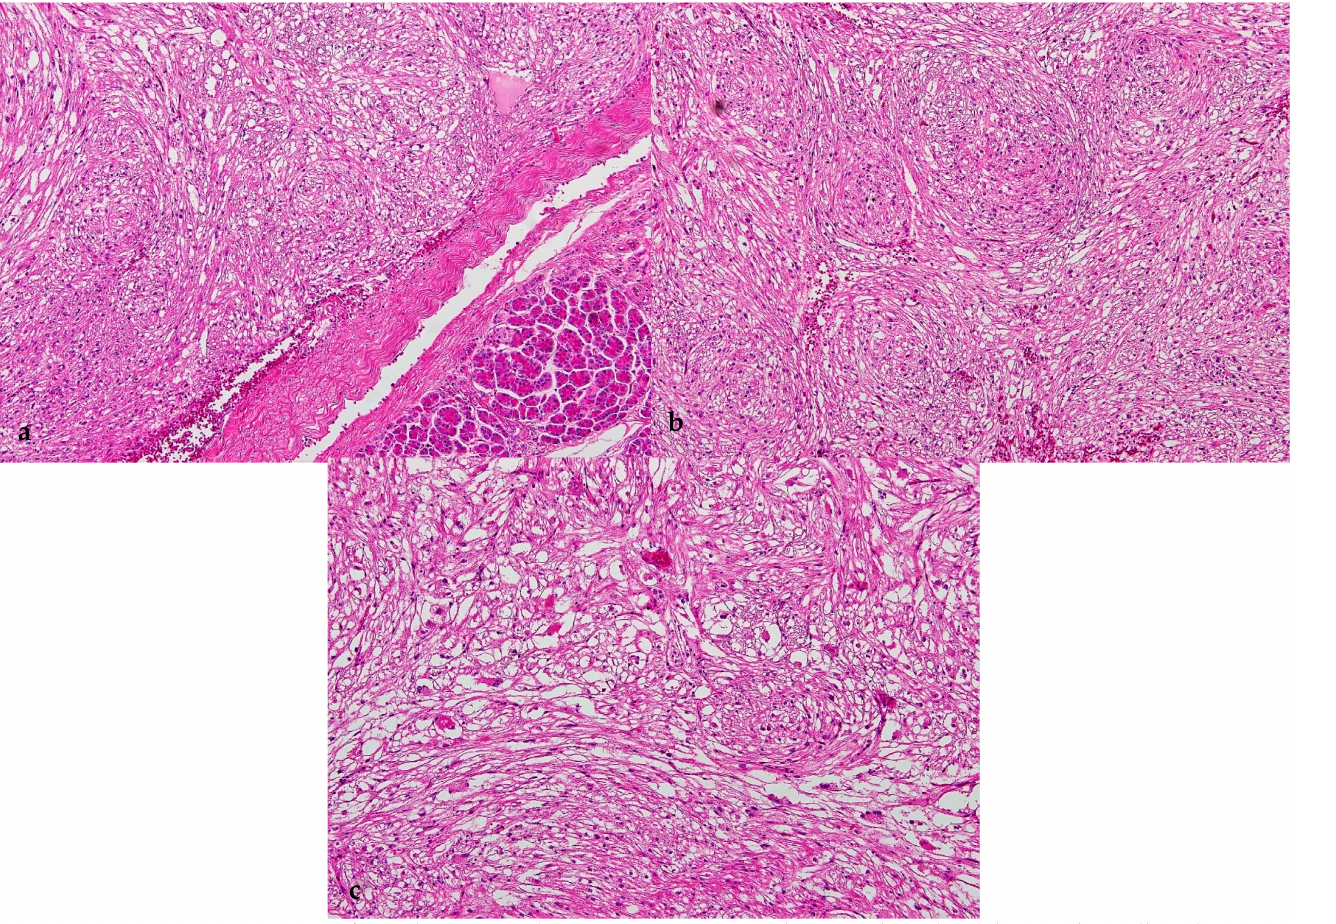
Figure 2. Histological features. Spindle cell tumor surrounded by fibrous capsule separating it from adjacent normal pancreatic acini (( a ), 100×), the tumor showed nodularity with spindly and epithe- lioid cells featuring clear to eosinophilic granular cytoplasm and rounded uniform nuclei (( b ),100×; ( c ), 200×).